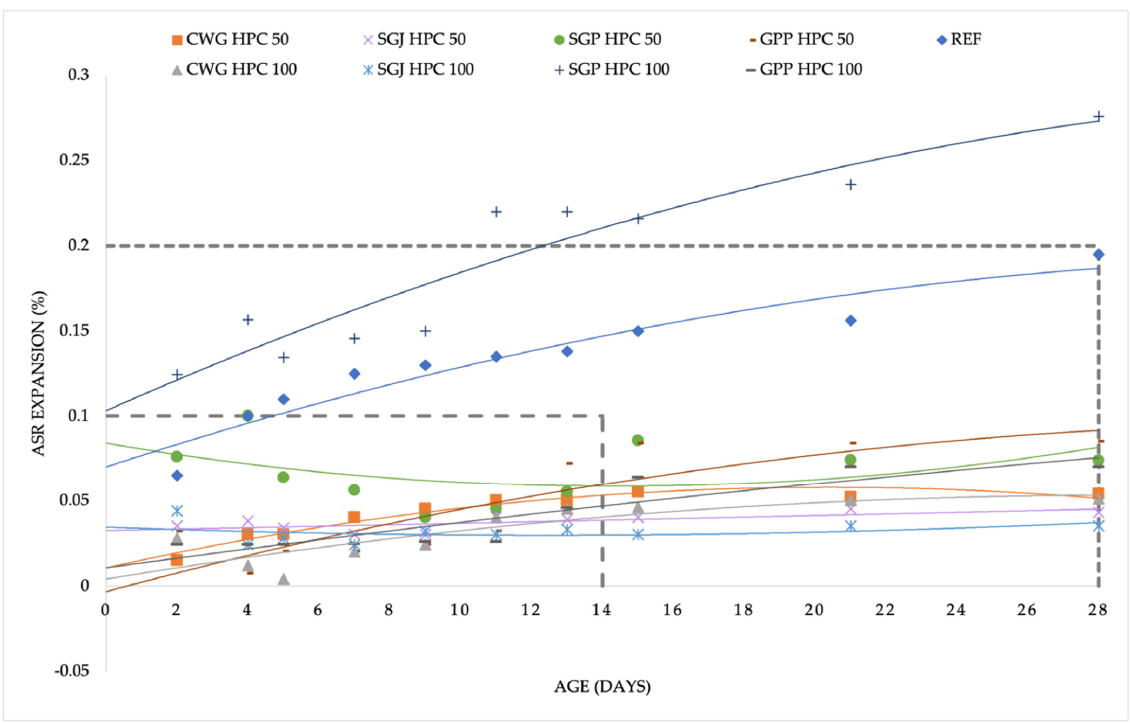
Figure 4. Summarized results of dependence of ASR expansion on time according to the TP137.